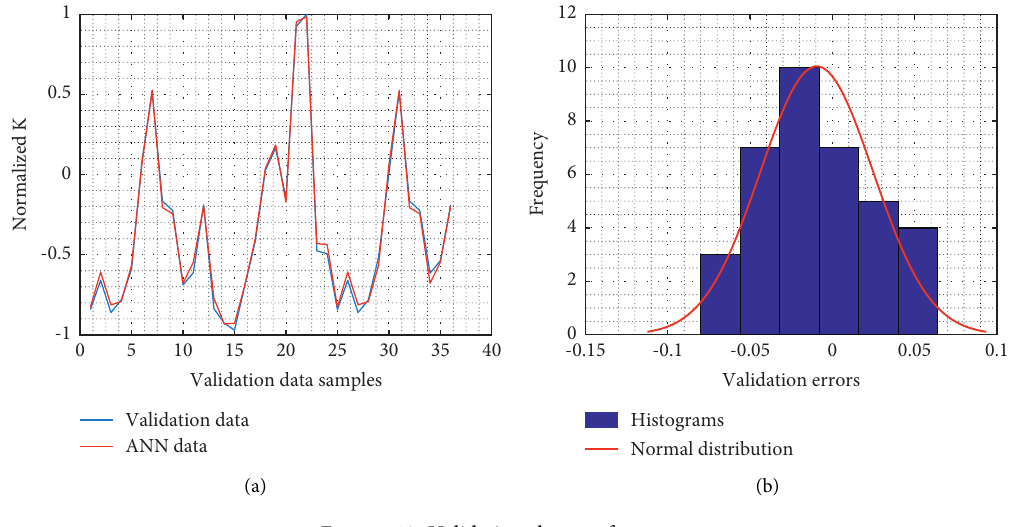
Figure 10: Validation data